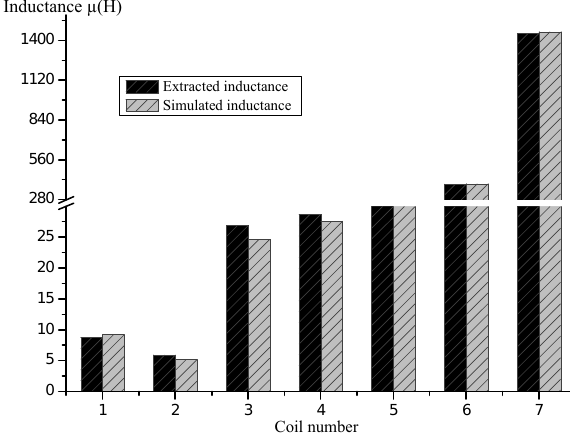
Figure 18. Wirelessly extracted and numerically computed induc- tance values of di ff erent open-ended micro